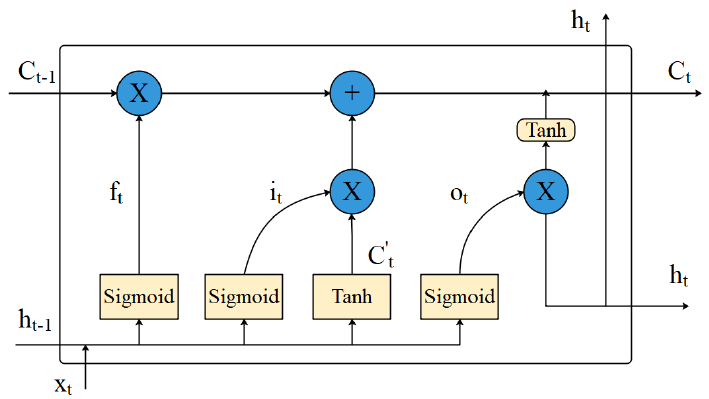
Fig. 1 . Structure of a long short-term memory